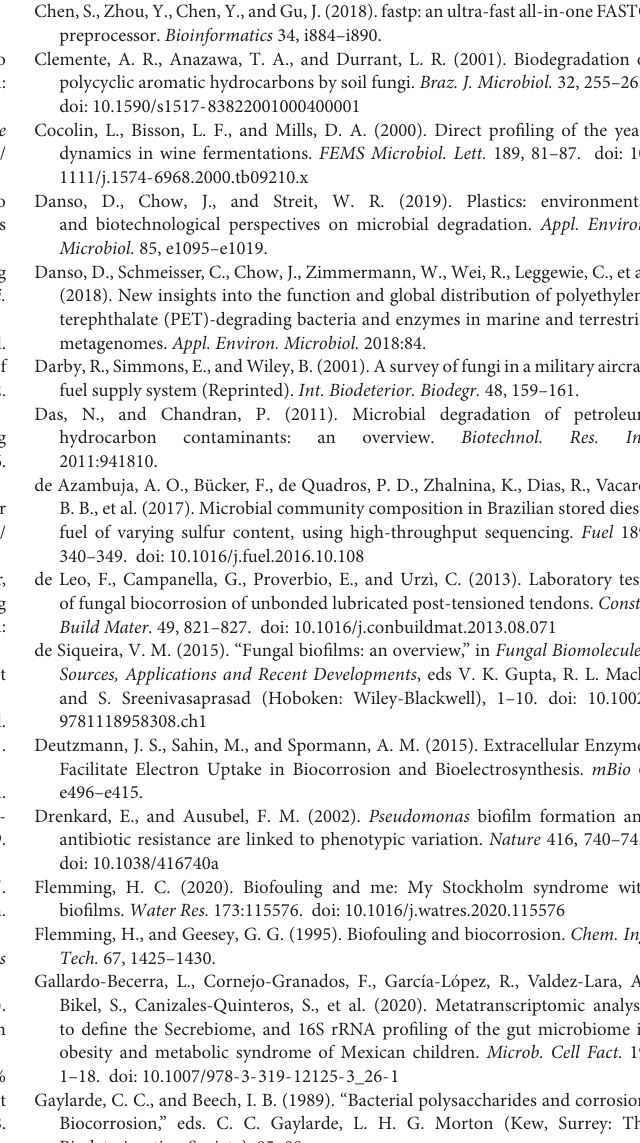
Supplementary Table 4 | Overall numbers of sequences and contigs generated for the transcriptome. Supplementary Table 5 | Top 250 expressed genes in the biofilm